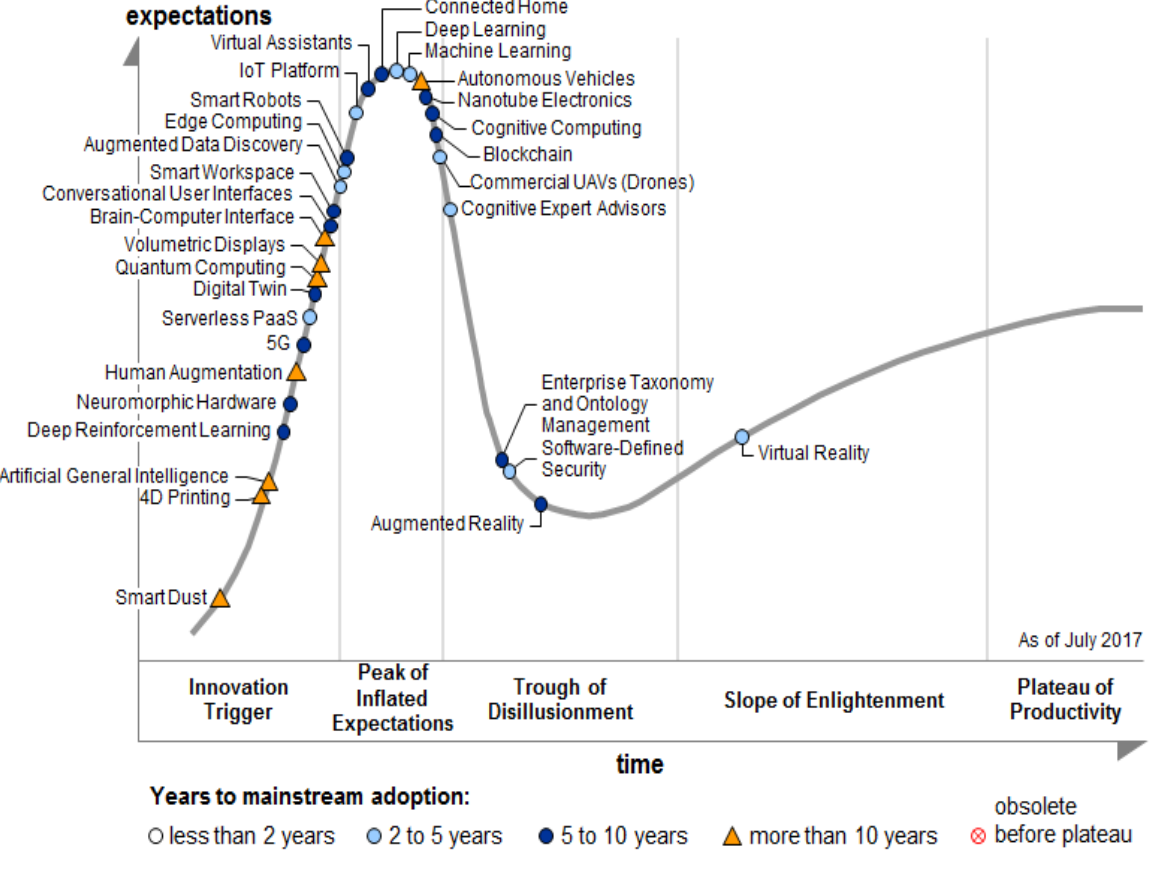
Figure 1. Gartner’s Hype